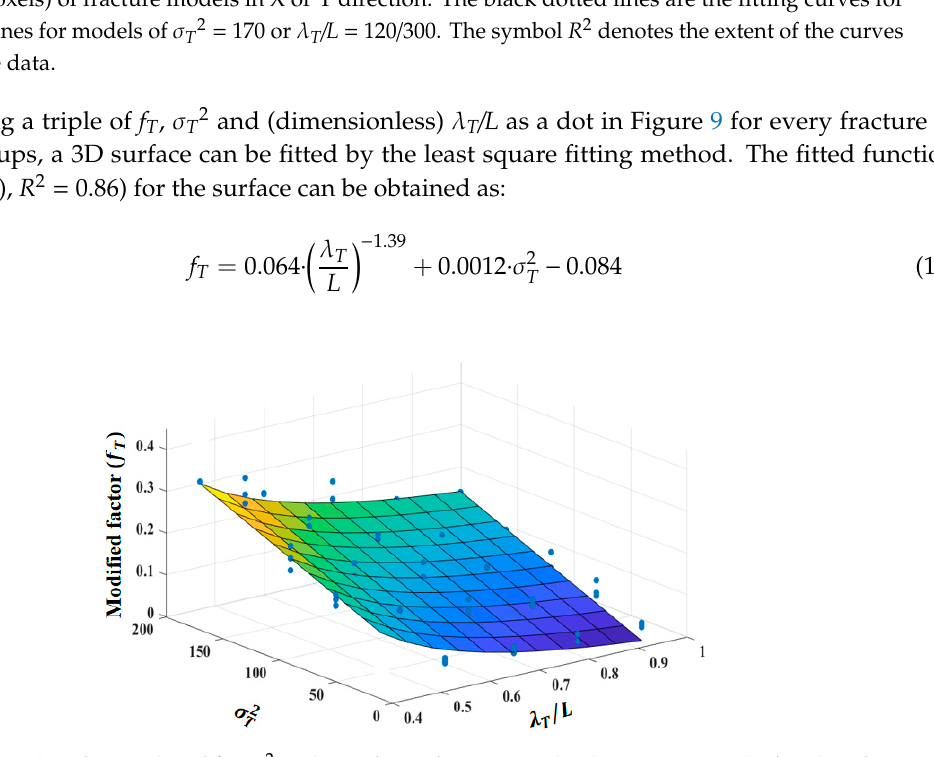
Figure 9. A plot of 75 triples of f T , σ T2 and λ T /L for 75 fractures in the three groups and a fitted surface. This reflects that the modified factor increases linearly with the undulation coefficient, and decreases with the correlation length as a power function. In addition, we found that the power in Equation (11) is − 1.39 and the power of the dotted lines in Figure 8b,c are closed to − 1.39, while the value in Figure 8a is − 0.99 and quite larger than − 1.39. The reason of this phenomenon is that the dotted lines in Figure 8a – c are the optimal fitting of the power formula for the black solid lines. Although, the power in Figure 8a differs greatly from that in Figure 8b,c, the coefficient of